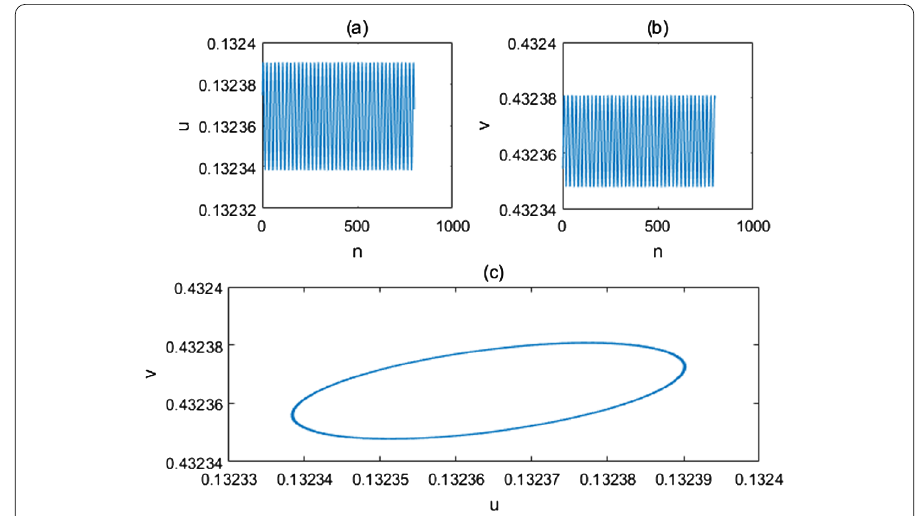
Figure 4 The repelling closed invariant curve in the controlled map (3.10) for s =